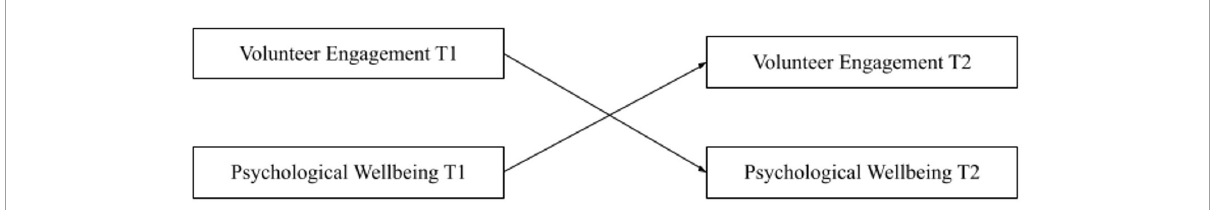
FIGURE1 Bidirectional effects model of volunteer engagement and psychological wellbeing. Single headed arrows represent regression, unbroken lines represent direct effects.